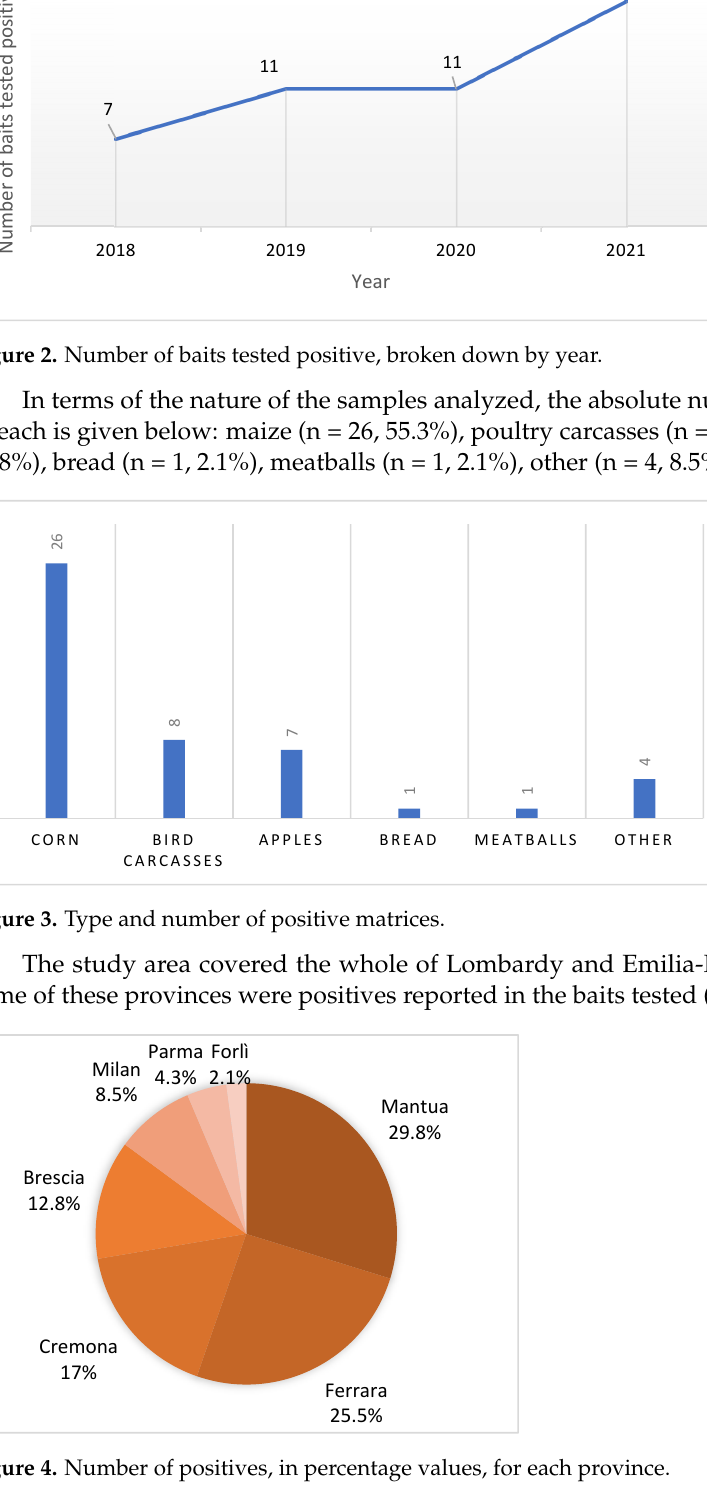
Figure 5. Number of cases per year in the first 3 provinces. Finally, examining the nature of the matrices found to be positive in each of the provinces, the following results were obtained: •